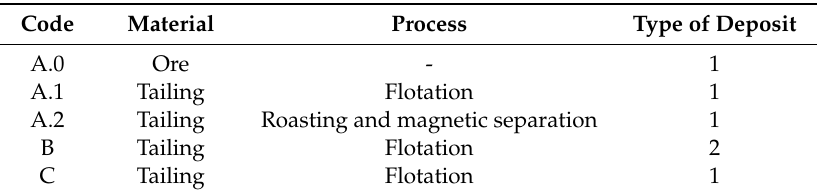
Table 6. Characteristics of the